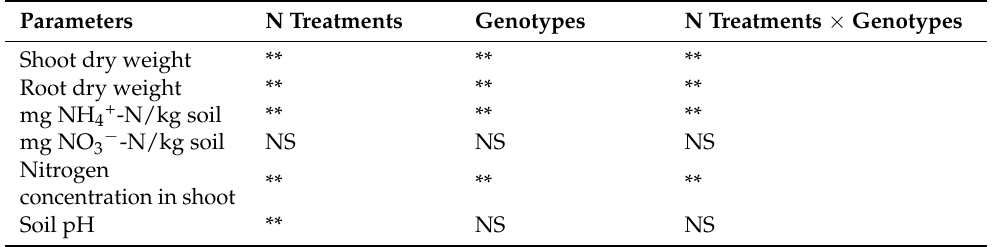
Table 4. Analysis of variance of the effect of nitrogen form and rates, canola genotype, and their interaction on canola growth and soil parameters (exp 2, vegetative growth stage 1,5). Parameters N Treatments Genotypes N Treatments × Genotypes